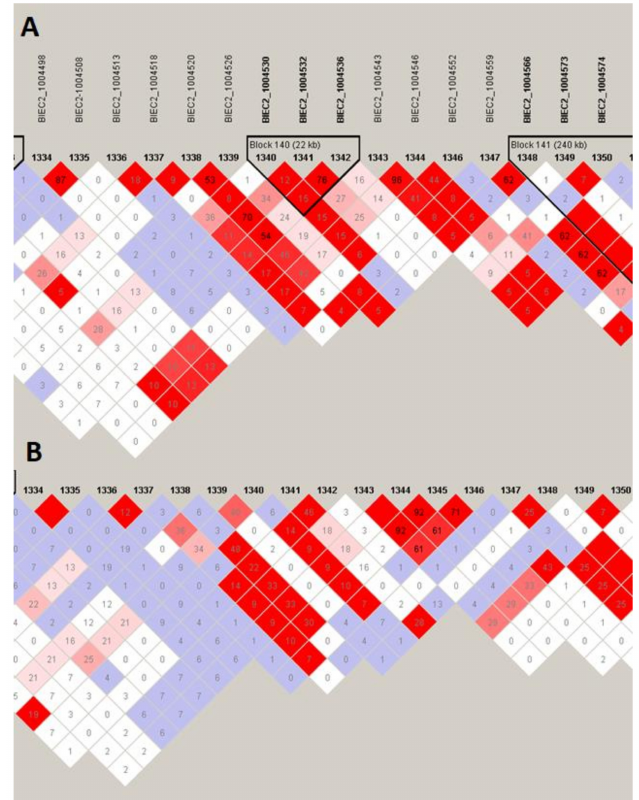
Figure 8. Linkage disequilibrium and haplotype block structure directly at the region divergently selected on ECA7 between Sok ó lski ( A ) and Sztumski ( B ) horses. Names of SNPs and their successive numbering on chromosome are given at the top of the figure. Black triangles mark the haplotype blocks. The colored squares represent the pairwise SNP linkage disequilibrium. D’ = 1.00 in the blank red squares. Numbers inside the squares are r 2 × 100. Detailed labeling of LD is described in Haploview manual